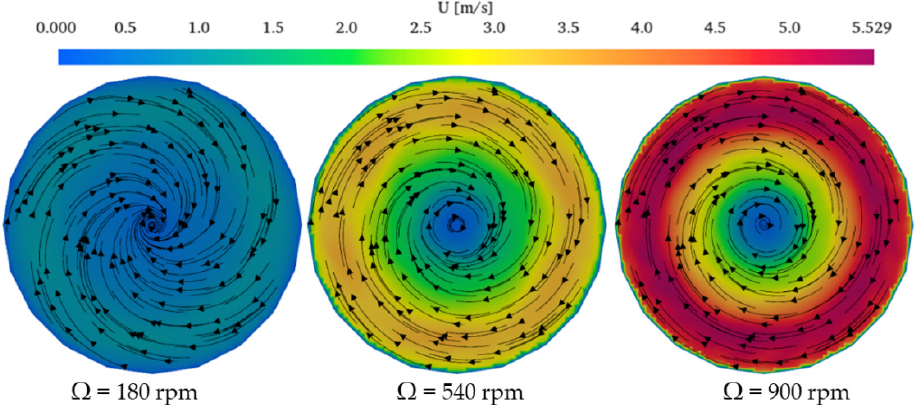
Figure 12. The velocity fields and streamlines are 2 mm above the interface in air.